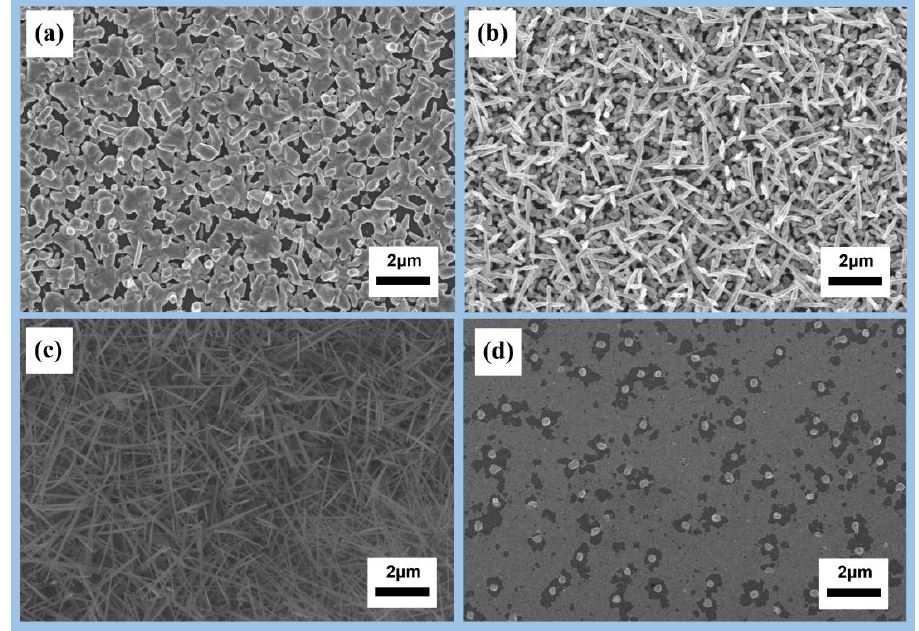
Figure 3. Morphologies of indium oxide nanowire synthesis at different gas flow rates: ( a ) 50 sccm Ar + 20 sccm O 2; ( b ) 70 sccm Ar + 20 sccm O 2; ( c ) 90 sccm Ar + 20 sccm O 2; ( d ) 110 sccm Ar + 20 sccm O 2 .